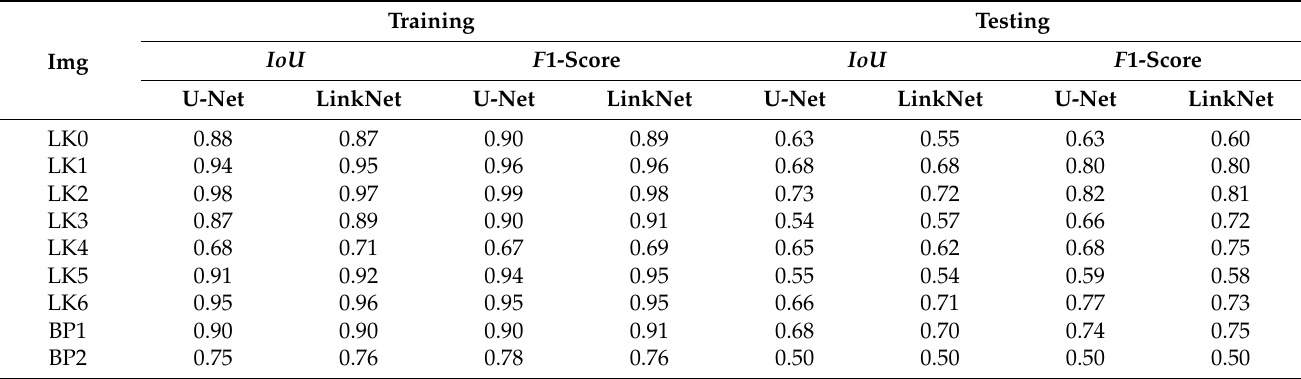
Table 1. Results from Experiment # 1 showing training and testing accuracy using both mean IoU and F 1-score for U-Net and LinkNet models for each image subset.